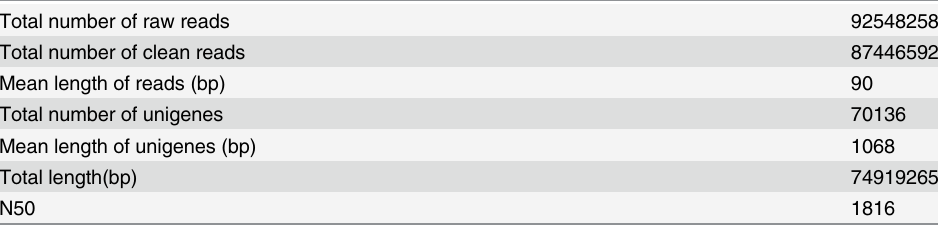
Table 1. Illumina RNA-Seq reads and de novo assembly statistics of